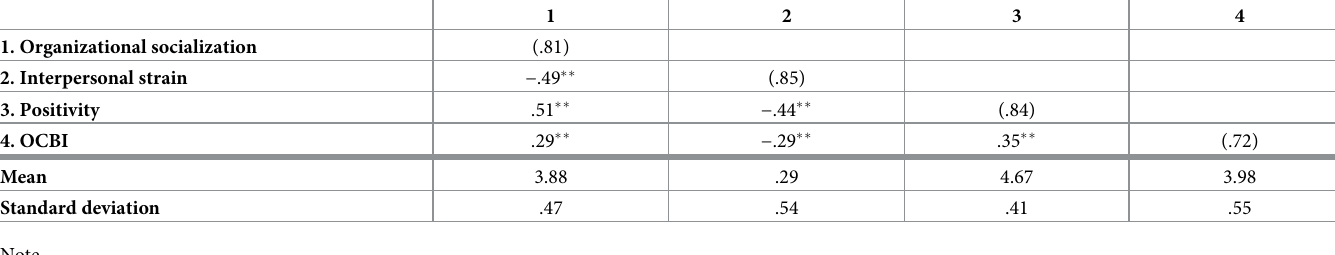
Table 1. Correlations, means and standard deviations for measured variables (N = 765). In diagonal alpha coefficients.